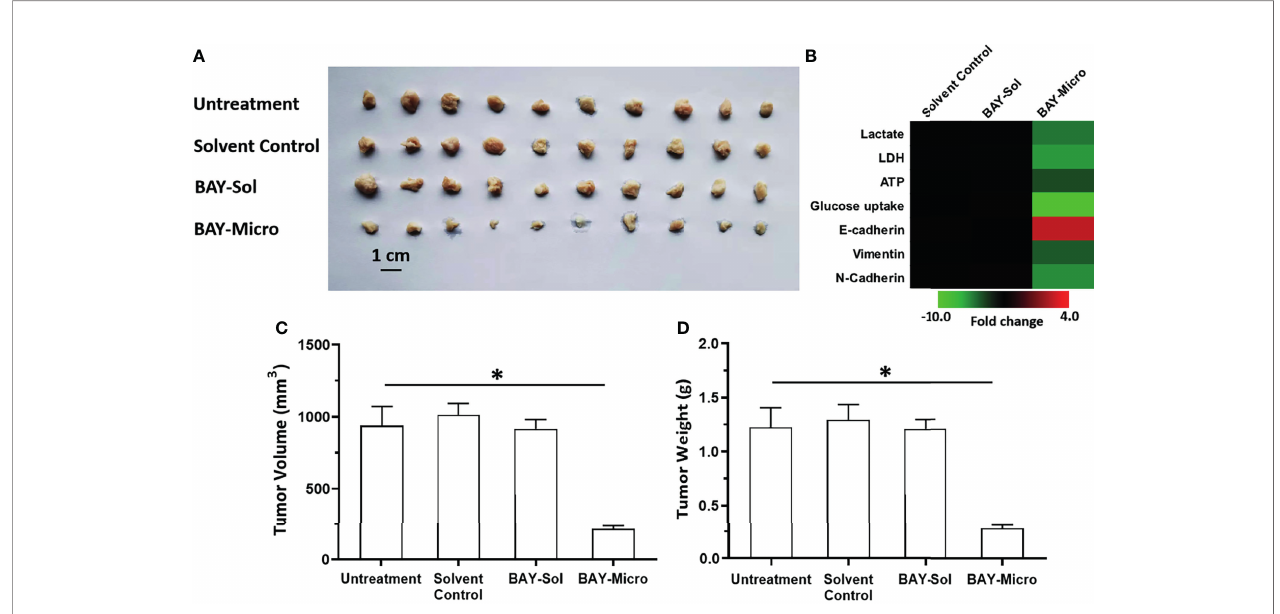
FIGURE 5 | Long-acting anti-tumor activation of BAY-876 microcrystalline on the subcutaneous growth of MHCC97-H cells. The MHCC97-H cells were injected into the nude mice to form tumor tissues. The solvent control, BAY-Sol (BAY-876 solution), BAY-Micro (Bay-876 microcrystalline) was directly injected into the subcutaneous tumor tissues. The results are shown as representative images of subcutaneous tumor tissues (A) , the heat-map showing the effects of each treatment on the Warburg effect or on the EMT related factors (B) . (C, D) Tumor volumes and weights. *P<0.05.